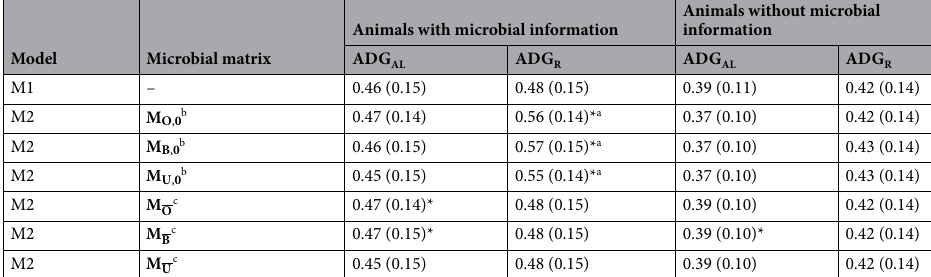
Table 5. Across 100 replicates average (SD) correlation coefficient between observed and mixed model predicted ADG AL and ADG R records using the fullDataset by expanding the microbial relationship covariance matrix in different ways. ADG AL , average daily gain in rabbits fed ad libitum; ADG R , average daily gain in rabbits fed under restriction; SD, standard deviation; M1, mixed model without microbial effects; M2, mixed model fitting the microbial effects; M O , microbial relationship covariance matrix defined from CSS normalized OTU counts, M B , microbial relationship covariance matrix defined from Bray–Curtis distance matrix; M U , microbial relationship covariance matrix defined from weighted Unifrac distance matrix. *M2 correlation between observed and predicted records significantly higher (bootstrapped paired t test) than M1 correlation after false discovery rate correction for multiple testing at the P < 0.05 level. a M2 correlation between observed and predicted records higher than M1 correlation in at least 80% of the replicates. b The expansion of the microbial relationship matrix ( M O , M B or M U ) was done by including ones in the diagonal and zeros outside the diagonal for the animals without microbial information. c The expansion of the microbial relationship matrix ( M O , M B or M U ) was done before computing the respective distance matrices, assigning to the animals without microbial information the cage-average of the CSS normalized OTU counts.